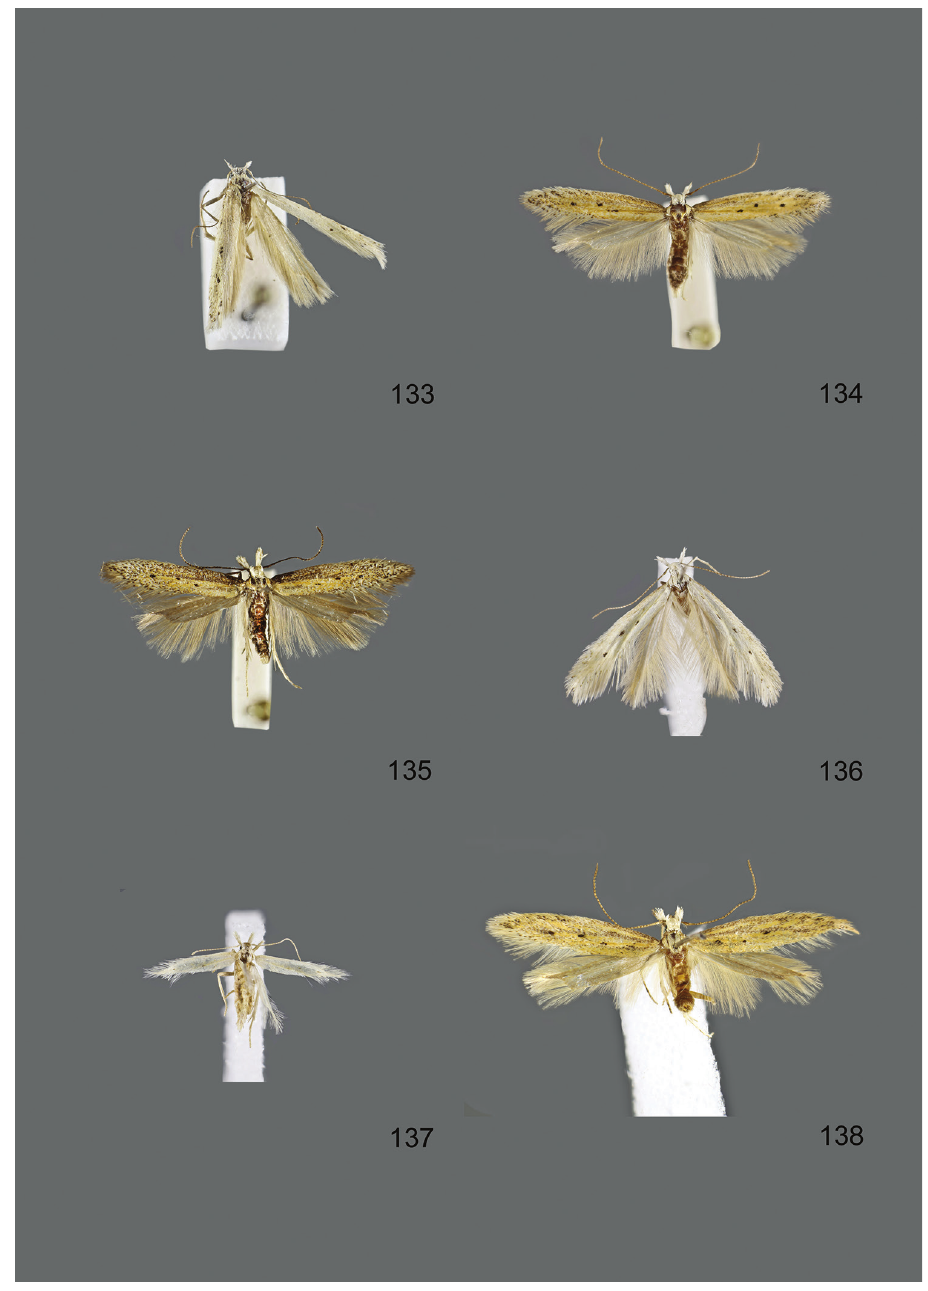
Figures 133–138. Megacraspedus adults in dorsal view. 133 M. multipunctellus sp. n. – Holotype, male, Tur- key (ECKU) 134 M. teriolensis sp. n. – Paratype, male, Croatia (RCZT) 135 M. teriolensis sp. n. – Paratype, male, Slovenia (NMPC) 136 M. korabicus sp. n. – Holotype, male, Macedonia (TLMF) 137 M. korabicus sp. n. – Paratype, female, Macedonia (TLMF) 138 M. quadristictus Lhomme, 1946 – male, France